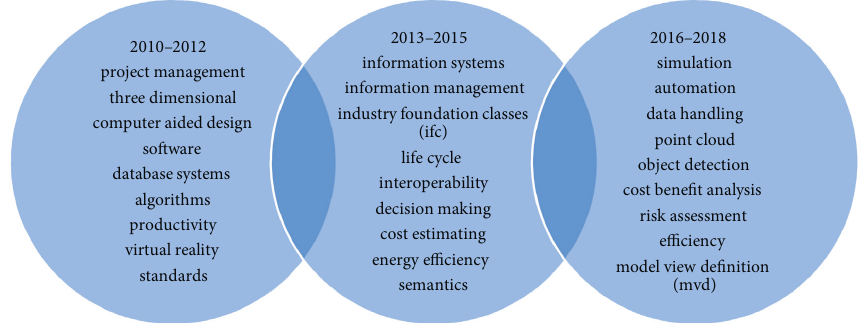
Figure 9: Evolvement directions of BIM in structural